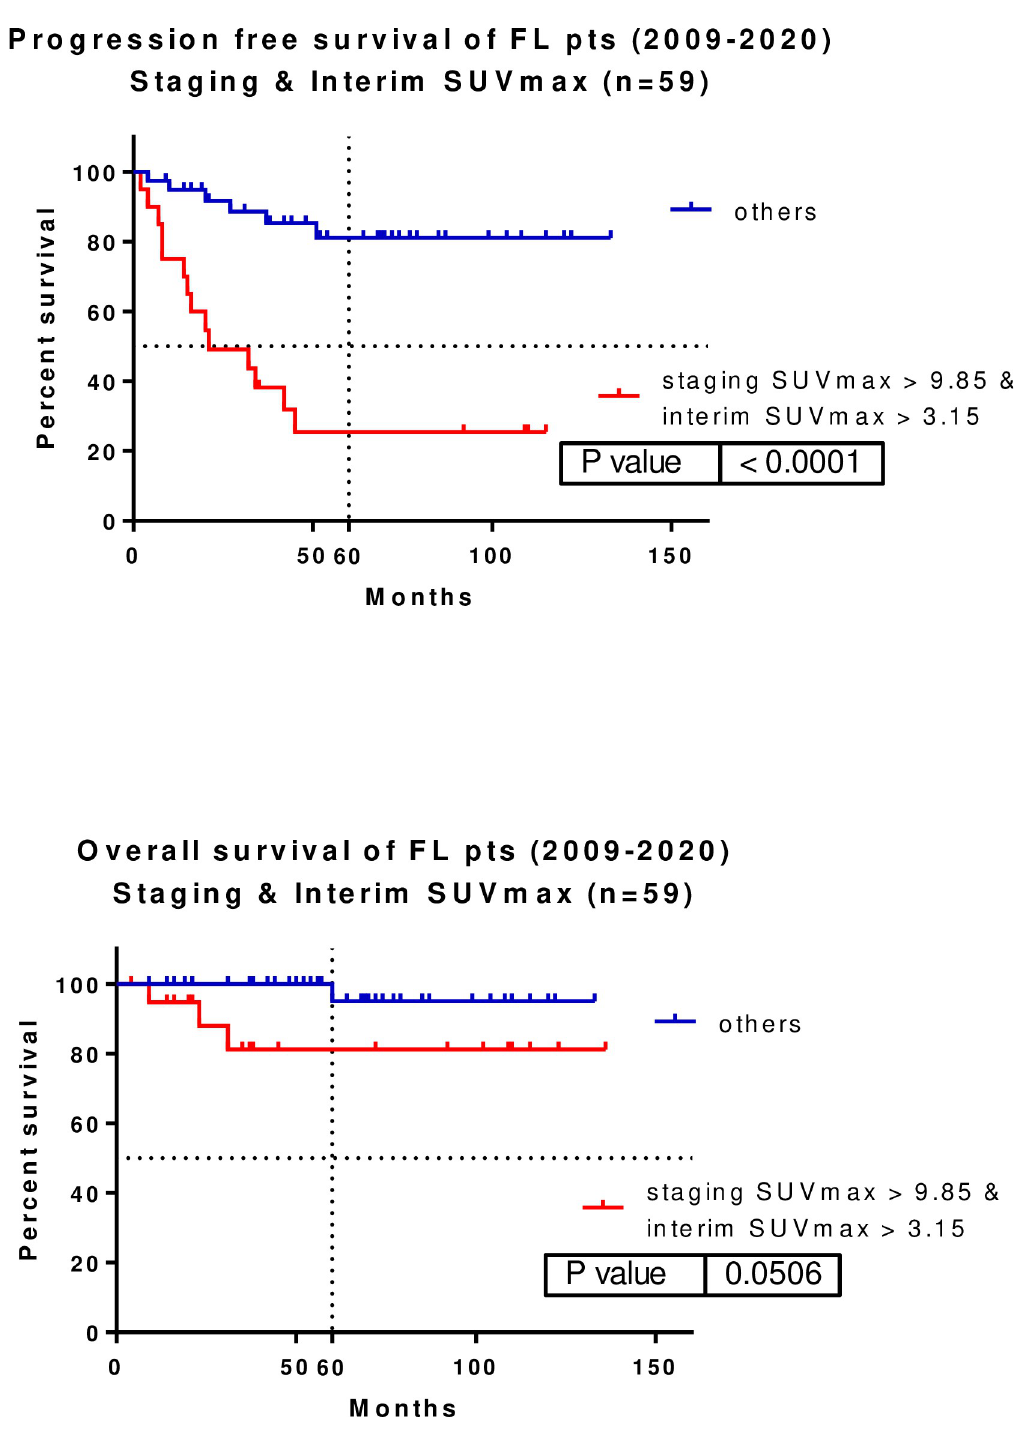
Fig 6. Combining patients with staging SUVmax > 9.85 and interim SUVmax > 3.15, a high-risk group of FL patients can be identified (p < 0.0001, HR: 0.1037, 95%CI: 0.03811–0.2824). Five-year PFS was 81.035 vs. 25.45%. The PFS difference is translated into OS disadvantage (p = 0.0506, HR: 0.1187, 95%CI: 0.01401–1.005). Five-year OS was 95.00 vs. 81.20%. SUVmax– maximum of standardized uptake value.